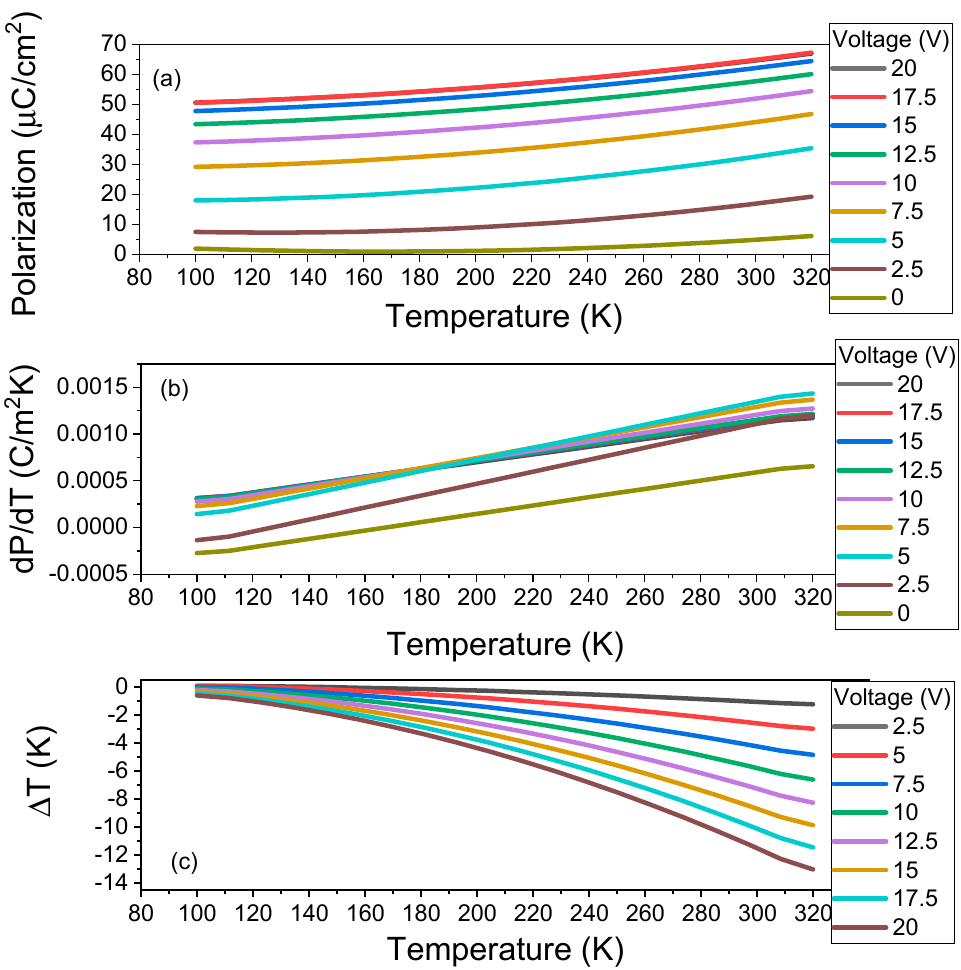
Figure 7. ( a ) The temperature dependence of polarization after switching for different voltages; ( b ) the indirectly evaluated pyroelectric coefficient as a function of temperature and different voltages; ( c ) the indirectly deduced adiabatic temperature variation as a function of temperature and voltages for epitaxial thin film Nb 2 O 5 /PZT/SRO/STO.